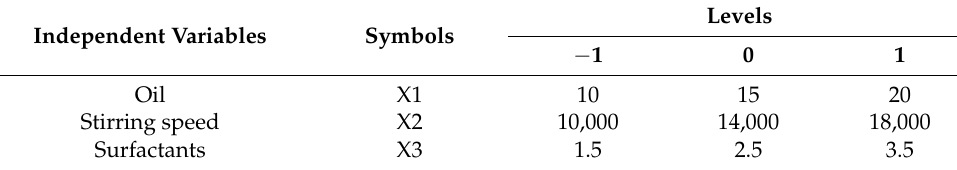
Table 2. Independent variables with 3 levels.